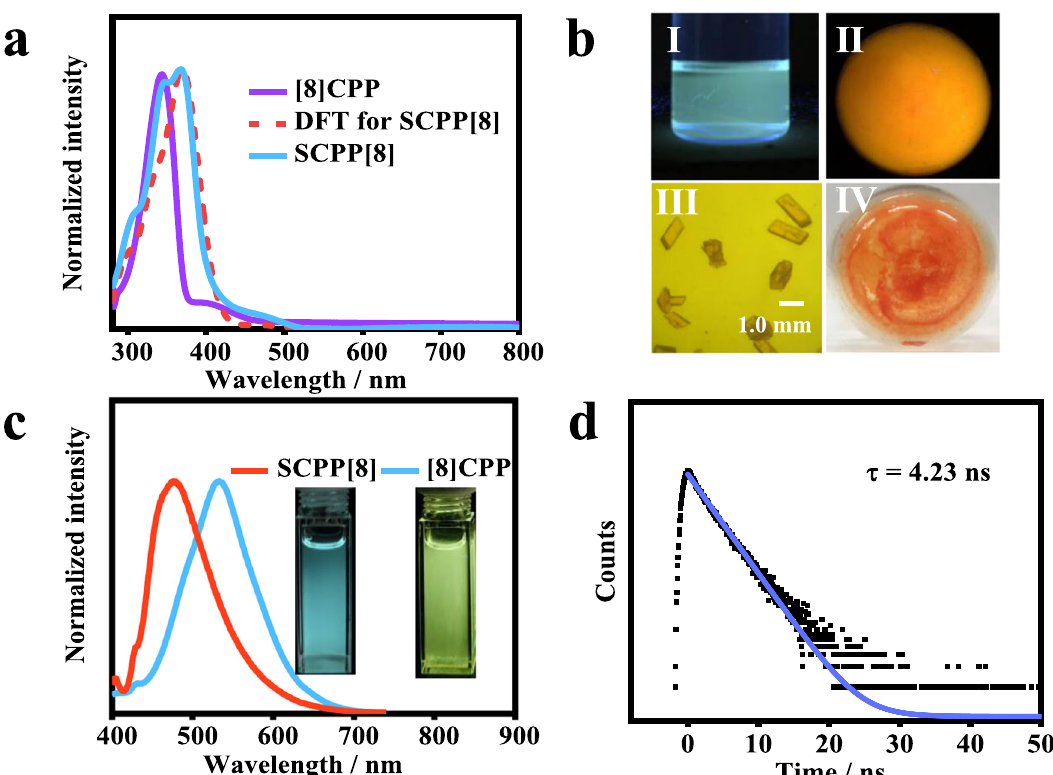
Fig. 4 Photophysical properties of SCPP[8]. a UV – Vis absorption spectra of SCPP[8] (blue) and [8]CPP (purple) in THF. Simulated curve of UV spectrum for SCPP[8] (dotted line). b Photos of SCPP[8] in THF solution (I), as powder (II) under 365 nm UV light, as crystal (scale bar: 1.0 mm) (III), and as powder (IV) under daylight. c Fluorescence spectra of SCPP[8] (red) and [8]CPP (blue) in THF. Insert: [8]CPP and SCPP[8] in THF solution under 365 nm UV light. d Emission lifetime for SCPP[8]